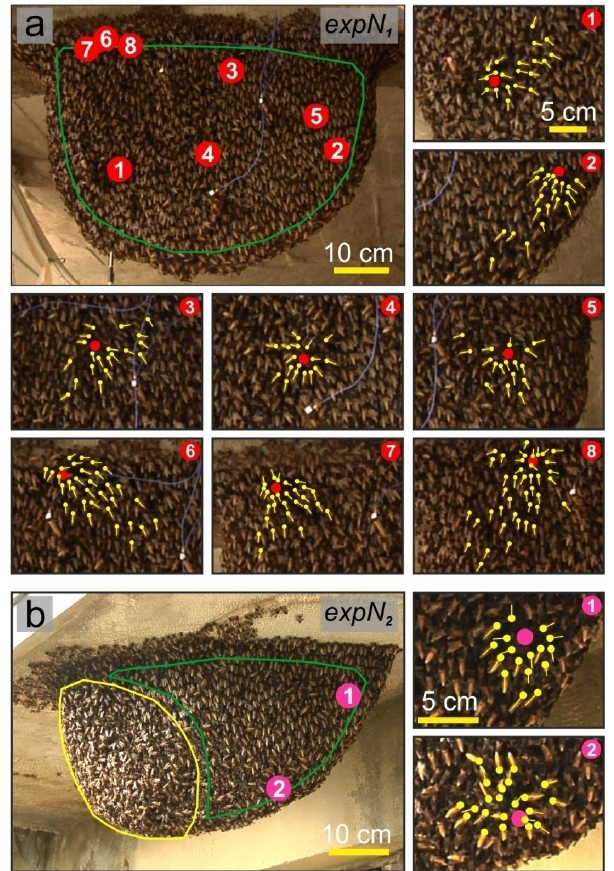
Figure 4. Mobilisation of guards against “non-nestmate” scout bees in expN expN ( b ). In the mouth zone (sketched by the open yellow polygon, only developed in 2 expN ) foraging bees depart and arrive, while the quiescent zone (green polygons) is the 2 largest part of the bee curtain where the bees are positioned with their heads up and the abdomens down; the complementary areas are the rim zones at the sides and the attachment zone on the top (not marked). Red full circles in panel a (see subpanels a1–a8) and ( b ) magenta full circles in panel b (see subpanels b1–b2) refer to the episodes and places where scouts had landed. Immediately after landing, guards grabbed the invader and others collectively moved towards the invader. Yellow dots mark the thoracic positions of the guards, yellow lines mark the direction of their long body axis (see movies